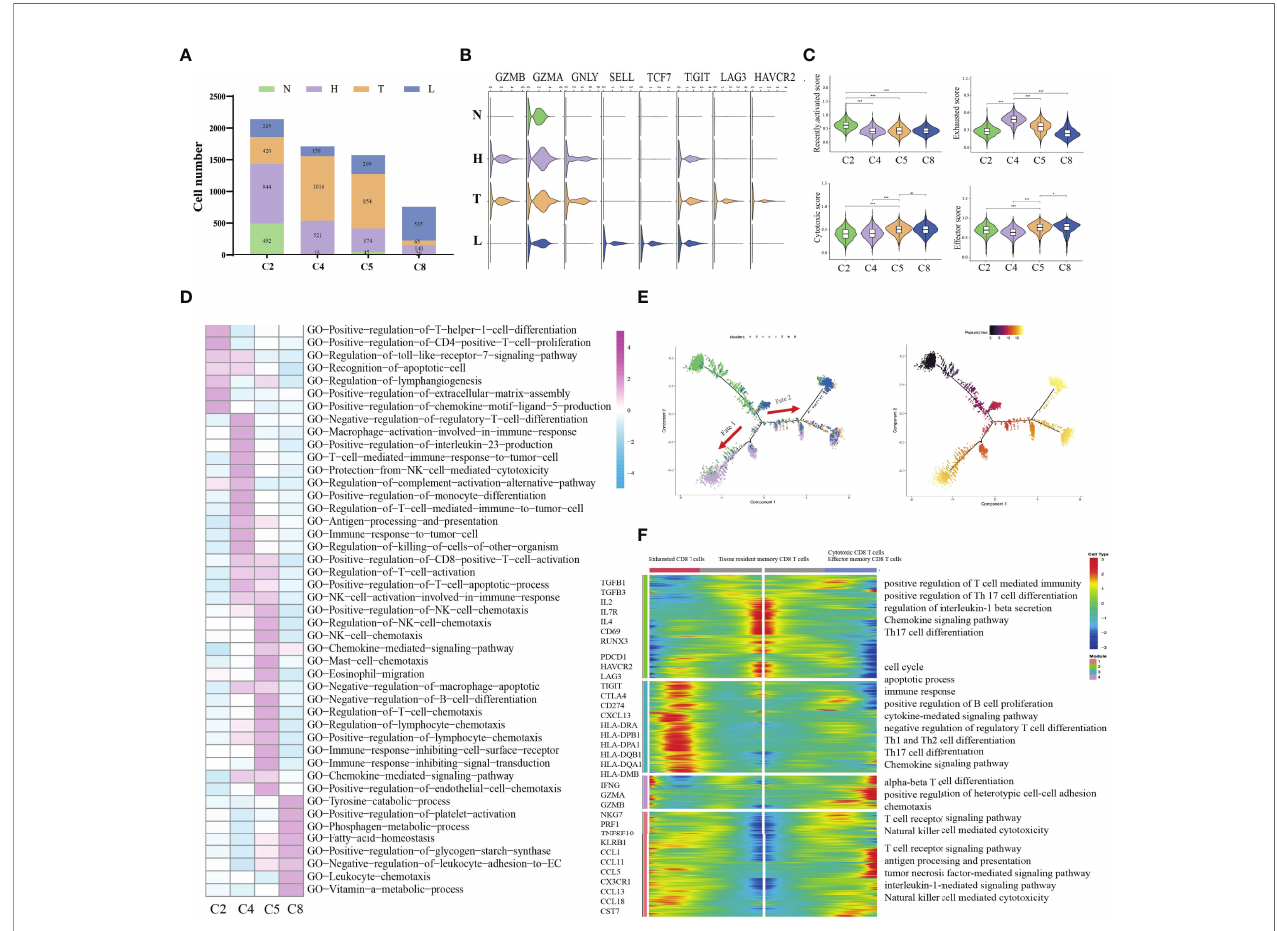
FIGURE 3 | Difference of immune state among four groups (N, H, T, and L). Proportions of each CD8+ T cell cluster among four groups (A) . Violin plots showing the distribution module score for selected genes for each CD8+ T cells cluster. Error bars indicated the means ± SD (B) . Violin plots showing the scores of functional modules for each cell CD8+ T cluster, using the AddModuleScore function. (*P < 0.05; ***P < 0.001) (C) . Heatmap indicating the enrichment of signaling pathway among four CD8+ T cells cluster (GSVA GO) (D) . Trajectory of all CD8+ T cell clusters from all group along pseudotime in a two-dimensional state-space de fi ned by Monocle2. Each point corresponds to a single cell, and each color represents a CD8+ T cell cluster (E) . Heatmap indicating the differentially expressed genes (rows) along the pseudotime (F) . NS, no signi fi